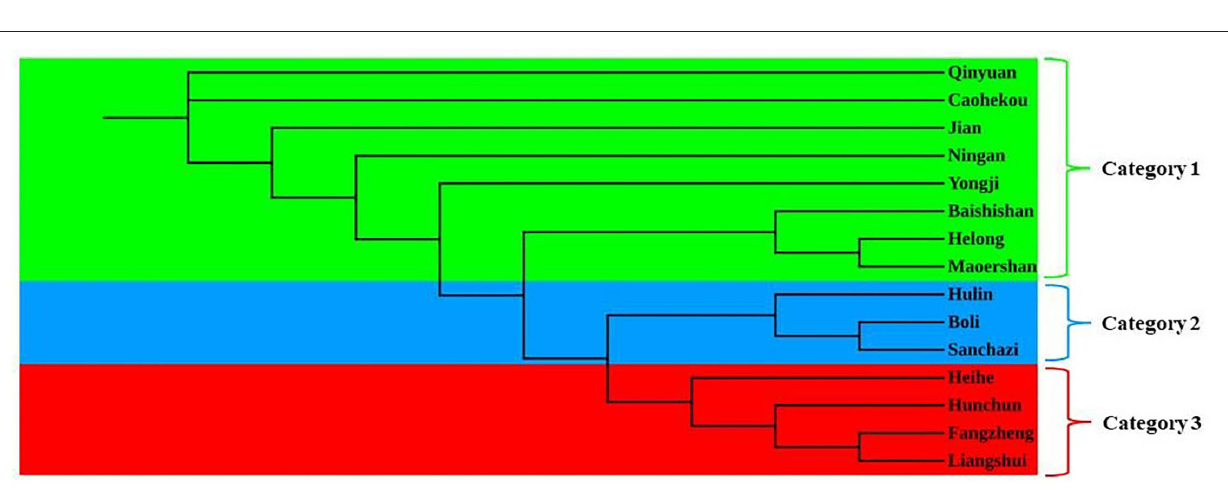
FIGURE 4 | Principal coordinate analysis (PCoA) based on the genetic distance of 343 individuals for J. mandshurica .